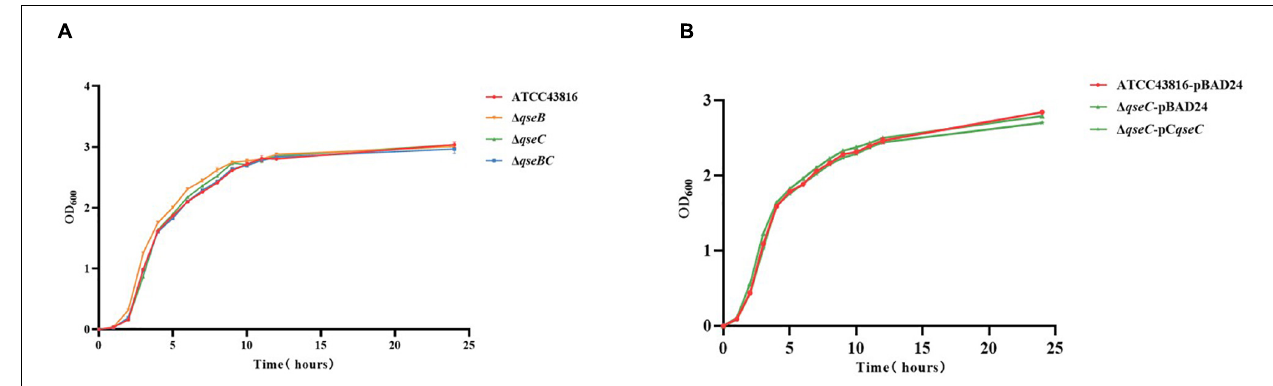
FIGURE 1 | (A) The growth rates of ATCC43816, (cid:49) qseB , (cid:49) qseC and (cid:49) qseBC were similar by measuring the optical density (OD 600 ) at per hour over a period of 24 h. (B) Growth curves of ATCC43816-pBAD24, (cid:49) qseC -pBAD24 and the complement strain (cid:49) qseC -pCqseC.